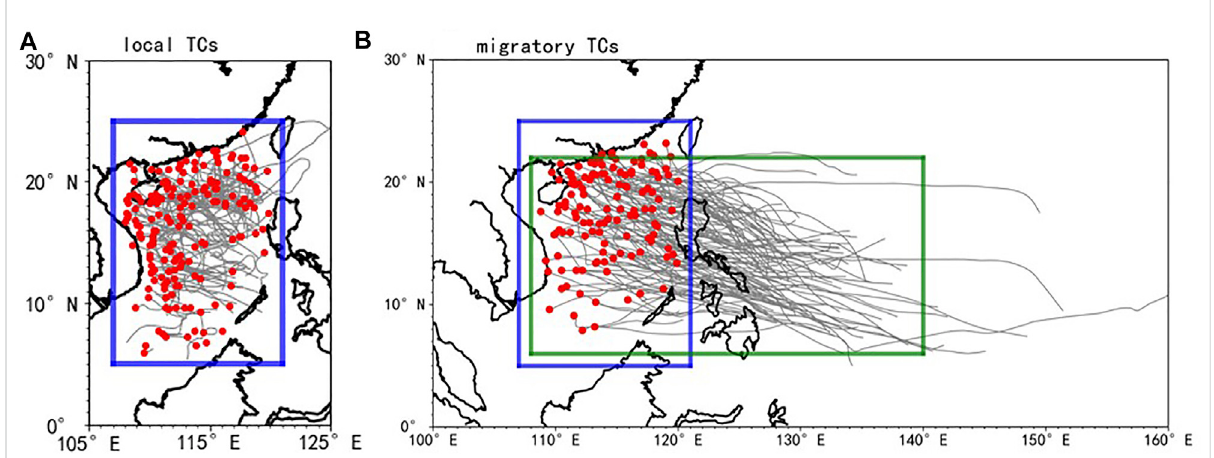
FIGURE 1 TCsLocationsthatreachedtheirLMI(reddots)andthetracksfromTCsgenesispositionstotheirLMIlocation(graylines)during1978 – 2020for (A) localTCsthatgeneratedandreachedLMIintheSCSand (B) migratoryTCsthatgeneratedintheWNPandreachedLMIintheSCS.Theblueboxes indicate the SCS region. Green box indicates the SCS and the WNP region. TCs data is from best-track dataset of JTWC during 1978 –